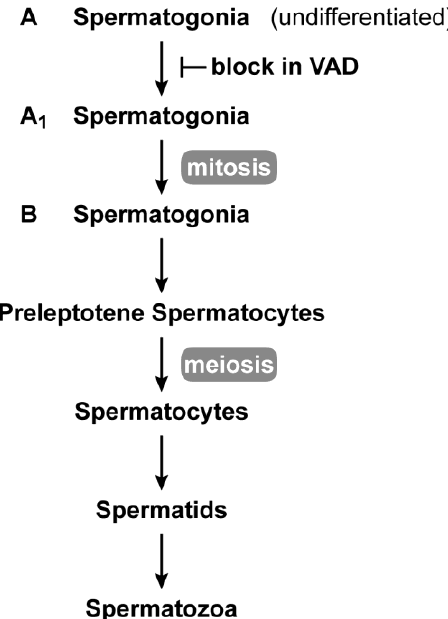
Figure 2. Spermatogenesis in the adult. Spermatogenesis takes place in the seminiferous epithelium of testis tubules from puberty through adulthood. Undifferentiated (A-type) spermatogonia at the base of the seminiferous epithelium divide mitotically until they enter the differentiation pathway to become A1 spermatogonia. A1 spermatogonia undergo division to A1–A4 and finally B spermatogonia. B spermatogonia divide to produce preleptotene (primary) spermatocytes that migrate away from the base of the seminiferous tubule to undergo meiosis. The first meiotic division produces secondary spermatocytes, and after the second meiotic division, spermatids (haploid cells) begin the differentiation process (spermiogenesis) to spermatozoa. In vitamin A deficiency, the transition from A to A1 spermatogonia is blocked